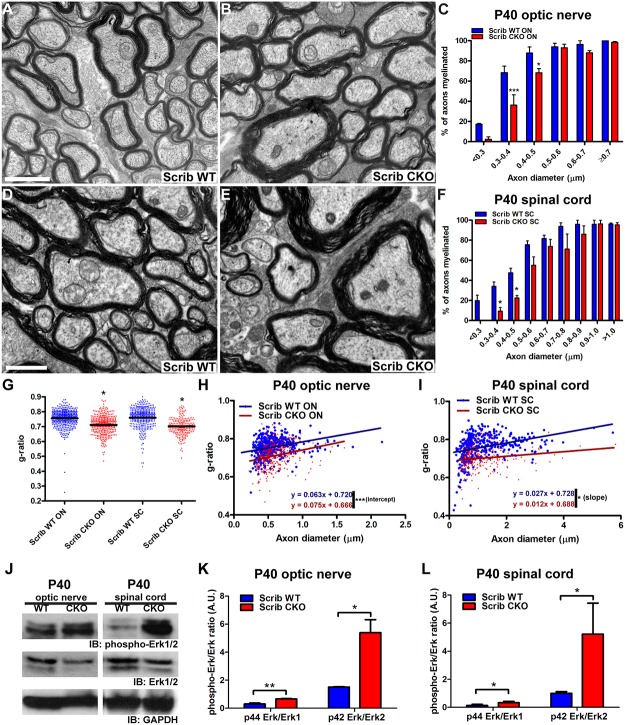
Scribble regulates myelin thickness and ERK activation in oligodendrocytes.A,B,D,E; At P40, decreased myelination of small-diameter axons in both optic nerve (B) and spinal cord (E) of Scribble cKO mice persists relative to wild-type littermates (A,D). This is quantified for optic nerve in C (0.3–0.4μm: WT = 68.4% ± 6.4%, cKO = 36.2% ± 10.1% myelinated, p = 0.0002; 0.4–0.5μm: WT = 87.8% ± 6.0%, cKO = 68.2% ± 4.1% myelinated, p = 0.0034) and for spinal cord in F (0.3–0.4 μm: WT = 34.0% ± 4.4%, cKO = 9.3% ± 3.7% myelinated, p = 0.039; 0.4–0.5μm: WT = 47.5% ± 4.5%, cKO = 22.3% ± 2.5% myelinated, p = 0.033) Numerical results here and below are presented as mean ± SEM. Two-way ANOVA with Bonferroni's multiple comparisons test was used. n = 3 animals per genotype. At least 200 axons were analysed per animal, per region. G–I; Axons that are myelinated in cKOs have thicker myelin sheaths than do axons of similar diameters in wild-type littermates, as decreased mean g-ratios were observed in both optic nerve and spinal cord (G; optic nerve: WT = 0.755 ± 0.004, cKO = 0.704 ± 0.016, p = 0.012; spinal cord: WT = 0.760 ± 0.010, cKO = 0.702 ± 0.008; p = 0.018; Student's t test was used to compare means from each animal. At least 100 g-ratios were analysed per animal, per region.). The best fit lines obtained by linear regression differed significantly between cKO and wild-type datasets in both optic nerve (H; WT: slope = 0.063 ± 0.012, intercept = 0.720 ± 0.007, cKO: slope = 0.075 ± 0.015, intercept = 0.666 ± 0.010; p = 0.548 [slope], p < 0.0001 [intercept]) and spinal cord (I; WT: slope = 0.027 ± 0.004, intercept = 0.728 ± 0.006, cKO: slope = 0.012 ± 0.005, intercept = 0.688 ± 0.007; p = 0.022 [slope]). J–L; Increased abundance of phosphorylated ERK1/2 relative to total ERK1/2 was observed in western blots of lysates of optic nerve and spinal cord from Scribble conditional mutants (J). The ratio of phospho-ERK/ERK densitometry is provided in arbitrary units for optic nerve (K): p44ERK/ERK1: WT: 0.306 ± 0.064, cKO: 0.666 ± 0.027, p = 0.0066; p42ERK/ERK2: WT: 1.511 ± 0.025 cKO: 5.391 ± 0.924, p = 0.014; and spinal cord (L): p44ERK/ERK1: WT: 0.127 ± 0.046 cKO: 0.335 ± 0.051, p = 0.038; p42ERK/ERK2: WT: 0.997 ± 0.069, cKO: 5.218 ± 1.278, p = 0.030, Student's t test was used. A,B: Scale bar = 1 um. E,F: Scale bar = 1.5 um. * p < 0.05, ** p < 0.01, *** p < 0.005 versus Scrib WT.